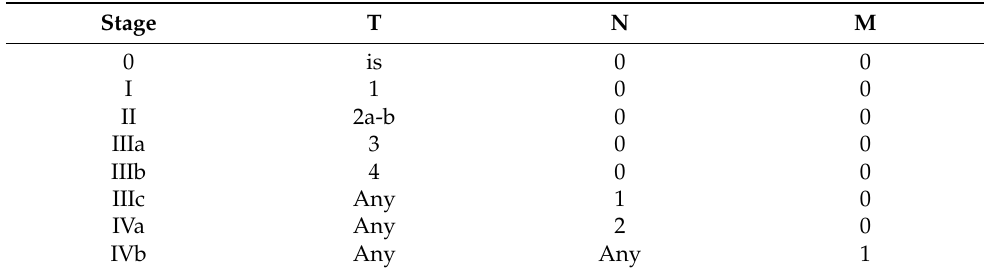
Table 1. Current American Joint Commission on Cancer staging system for cholangiocarcinoma. TIS = carcinoma in situ; T1 = tumour invades the subepithelial connective tissue; T2 = tumour invades the perifibromuscular connective tissue; T3 = tumour invades adjacent organs. N0 = no regional lymph nodes metastasis; N1 = metastasis to hepatoduodenal ligament lymph nodes; N2 = metastasis peripancreatic, periduodenal, periportal, celiac, and/or superior mesenteric artery lymph nodes. M0 = no distant metastasis; M1 = distant